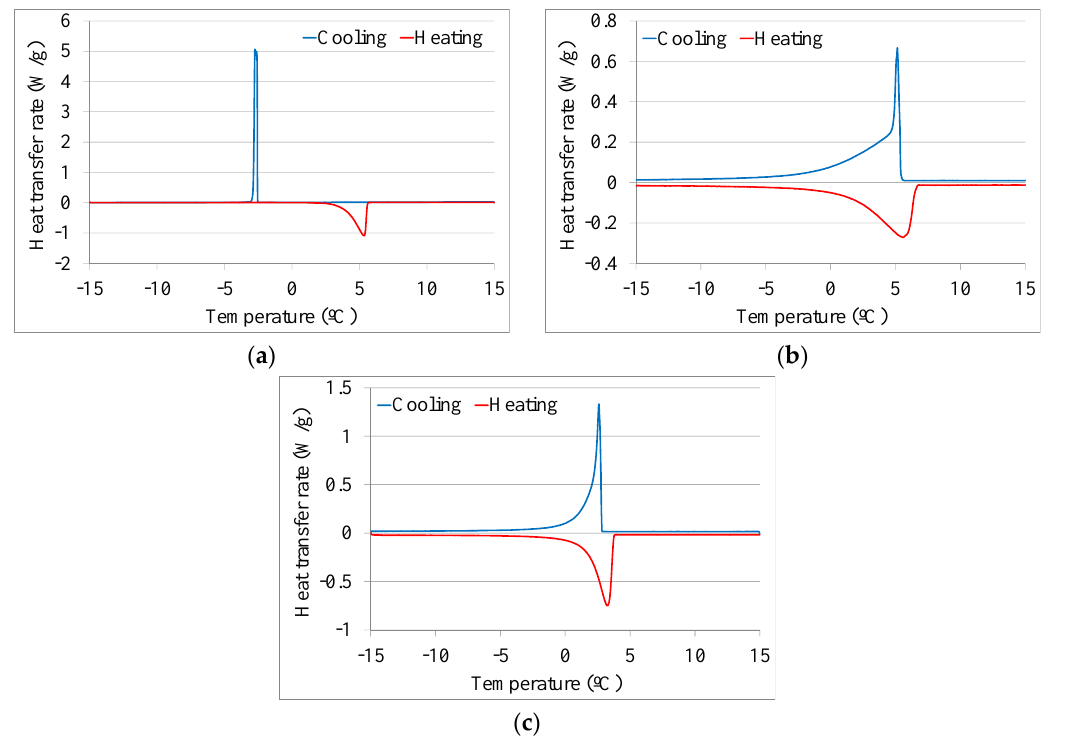
Figure 2. DSC analysis of three of the most promising pre-selected PCM for the MED system. ( a ) savE OM 03; ( b ) RT4; ( c ) RT3HC_1.